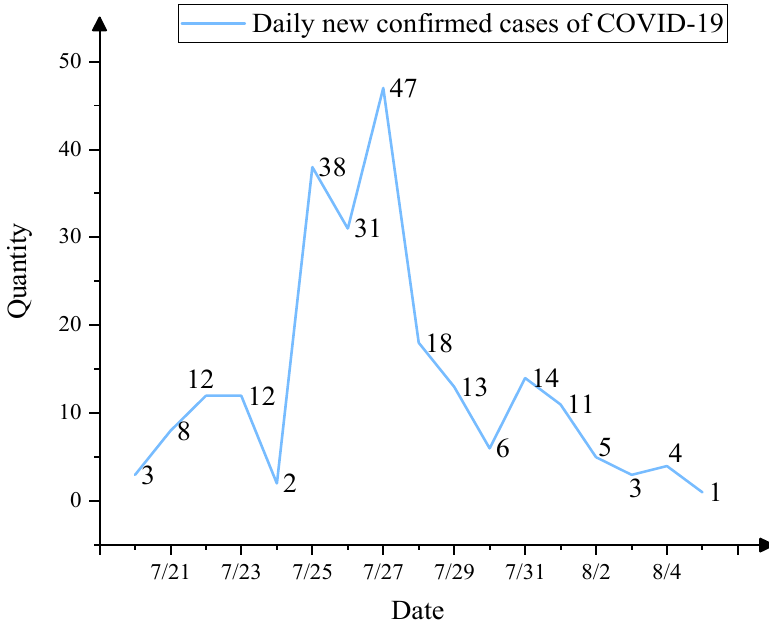
Figure 9. Daily new confirmed cases of COVID-19 from 7/20 to 8/5.